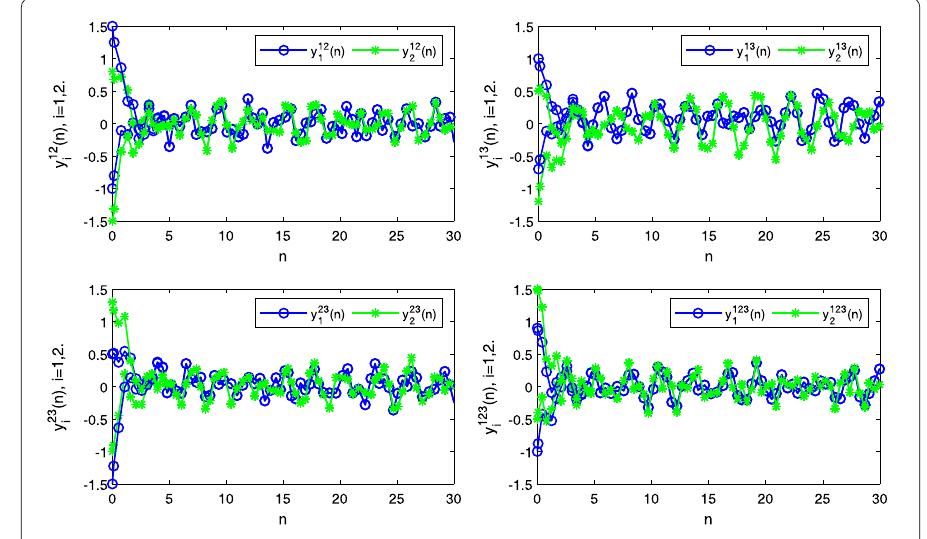
Figure 9 T = Z . Transient states of y 12 ( n ), y 13 ( n ), y 23 ( n ), and y 123 ( n )